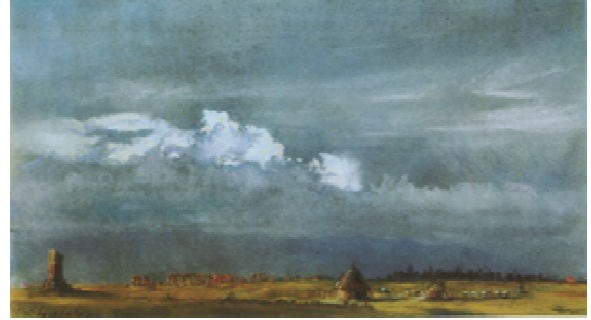
Figure 1. E. Gioia (1862-1937) campagna romana